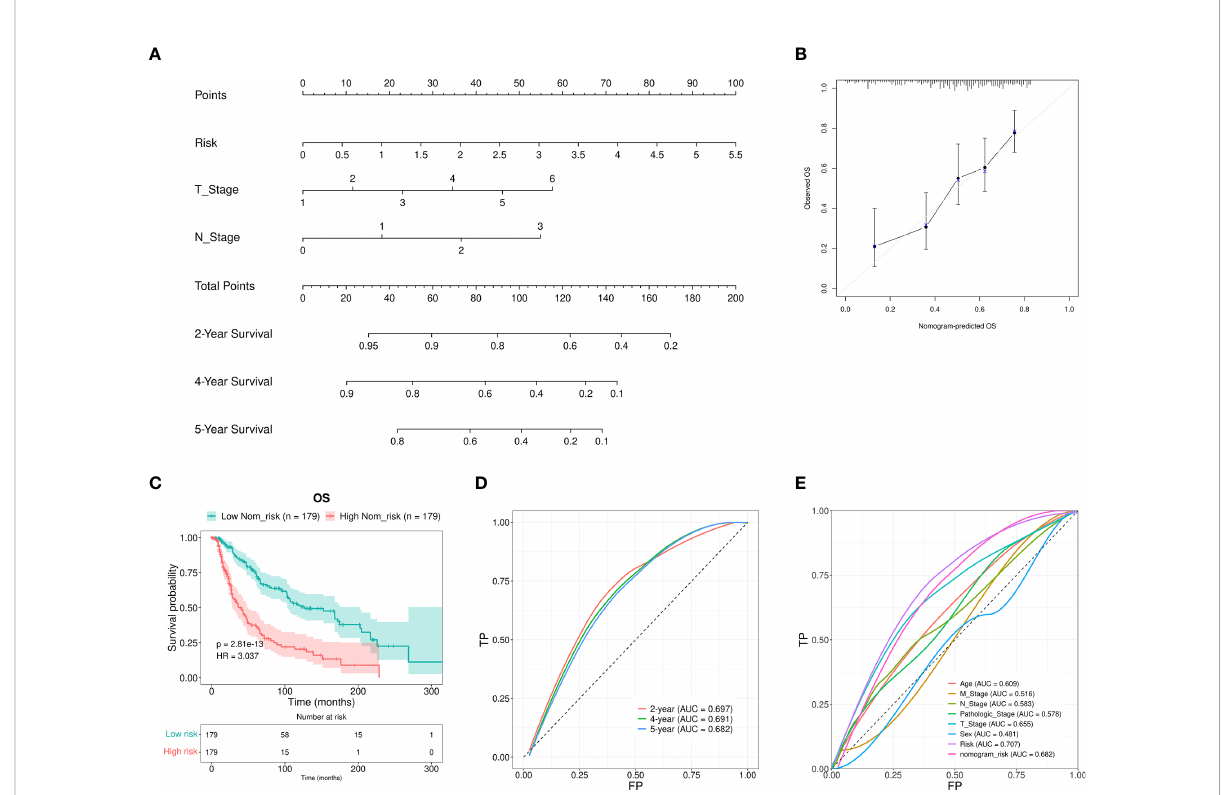
FIGURE 5 Nomogram construction and veri fi cation. (A) A nomogram that combined the clinical parameters and RS was applied to estimate the 2-, 4-, and 5-year OS for patients with SKCM. (B) The consistency of the calibration curve tests between the observed rates of OS and the survival rates that were predicted. (C) The OS rates for the nomogram samples for the low and high Nom-risk groups were analyzed using the Kaplan-Meier method. (D) The ROC curves and the AUCs at 2-, 4-, and 5-year survival as the predictive signature. (E) ROC curve of the RS and clinicopathological